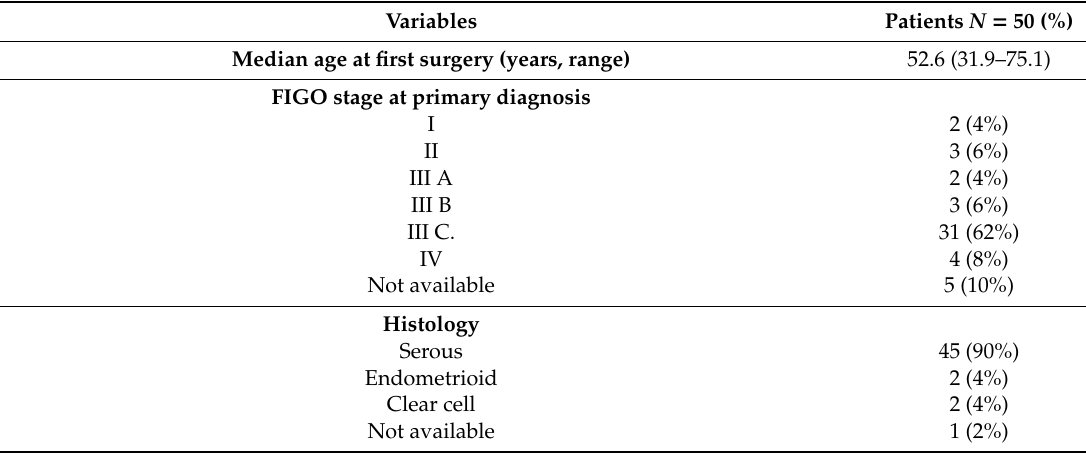
Table 1. Patient tumor-related and surgical